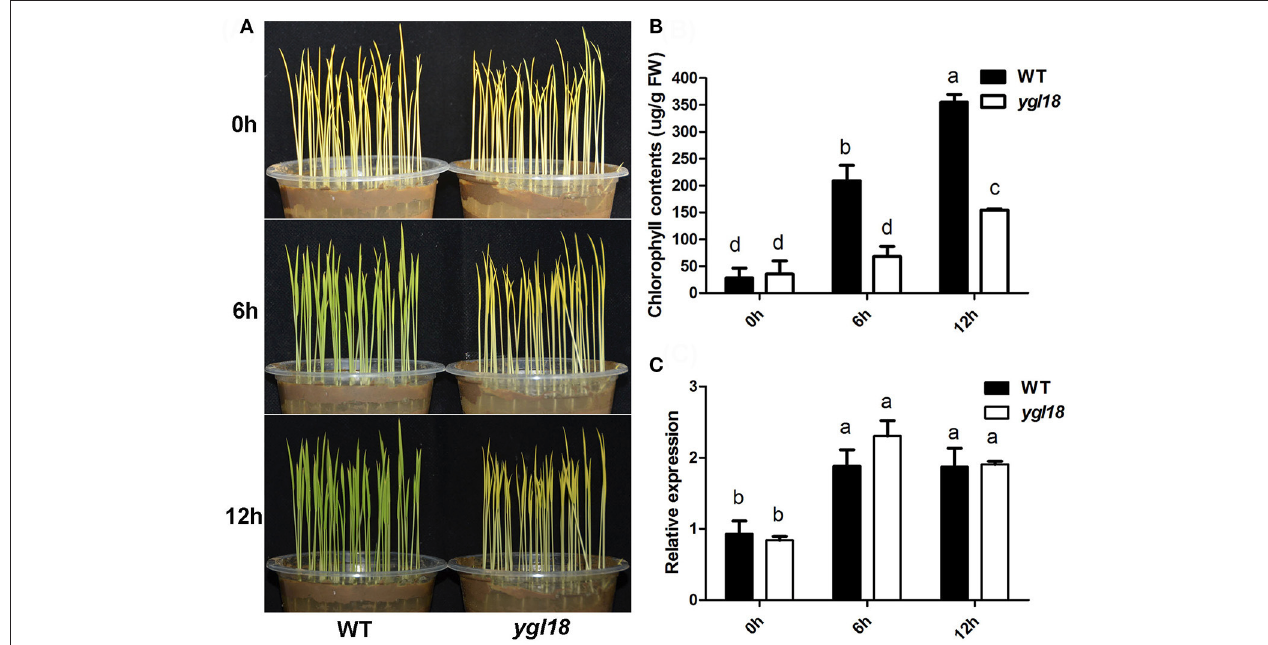
FIGURE 8 | Expression levels of YGL18 during the greening of etiolated seedlings. The 6-day-old etiolated seedlings of the wild type and ygl18 were exposed to light (150 µ mol m − 2 s − 1 ) for 0–12h. (A) Comparison of the greening speed between the wild-type and ygl18 seedlings. (B) Chlorophyll contents in the wild-type and ygl18 seedlings during greening. (C) Changes in transcript levels of YGL18 in the wild-type and ygl18 seedlings during greening. In (B,C) , data represent the mean ± SD of three biological replicates (one-way ANOVA analysis); FW, fresh weight. Different letters indicate values are statistically different based on a one-way ANOVA analysis.